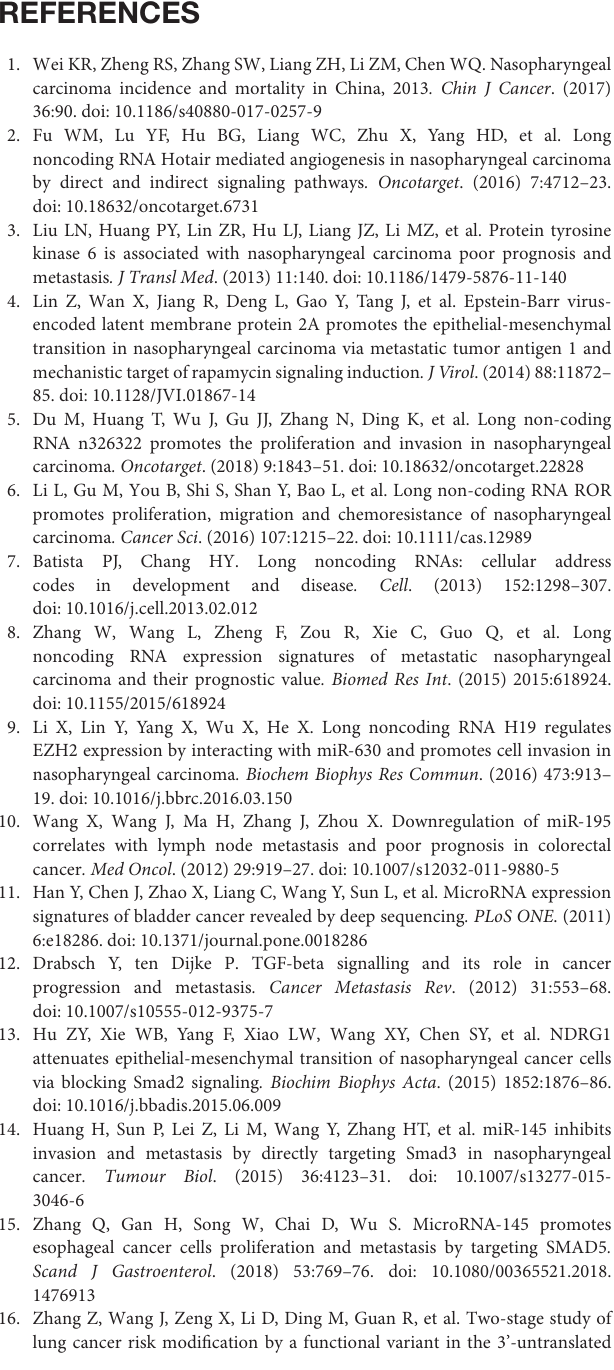
CNE-1 cell proliferation assessed by EdU assay. (D) CNE-1 cell apoptosis rate measured by flow cytometry. (E) CNE-1 cell migration measured by